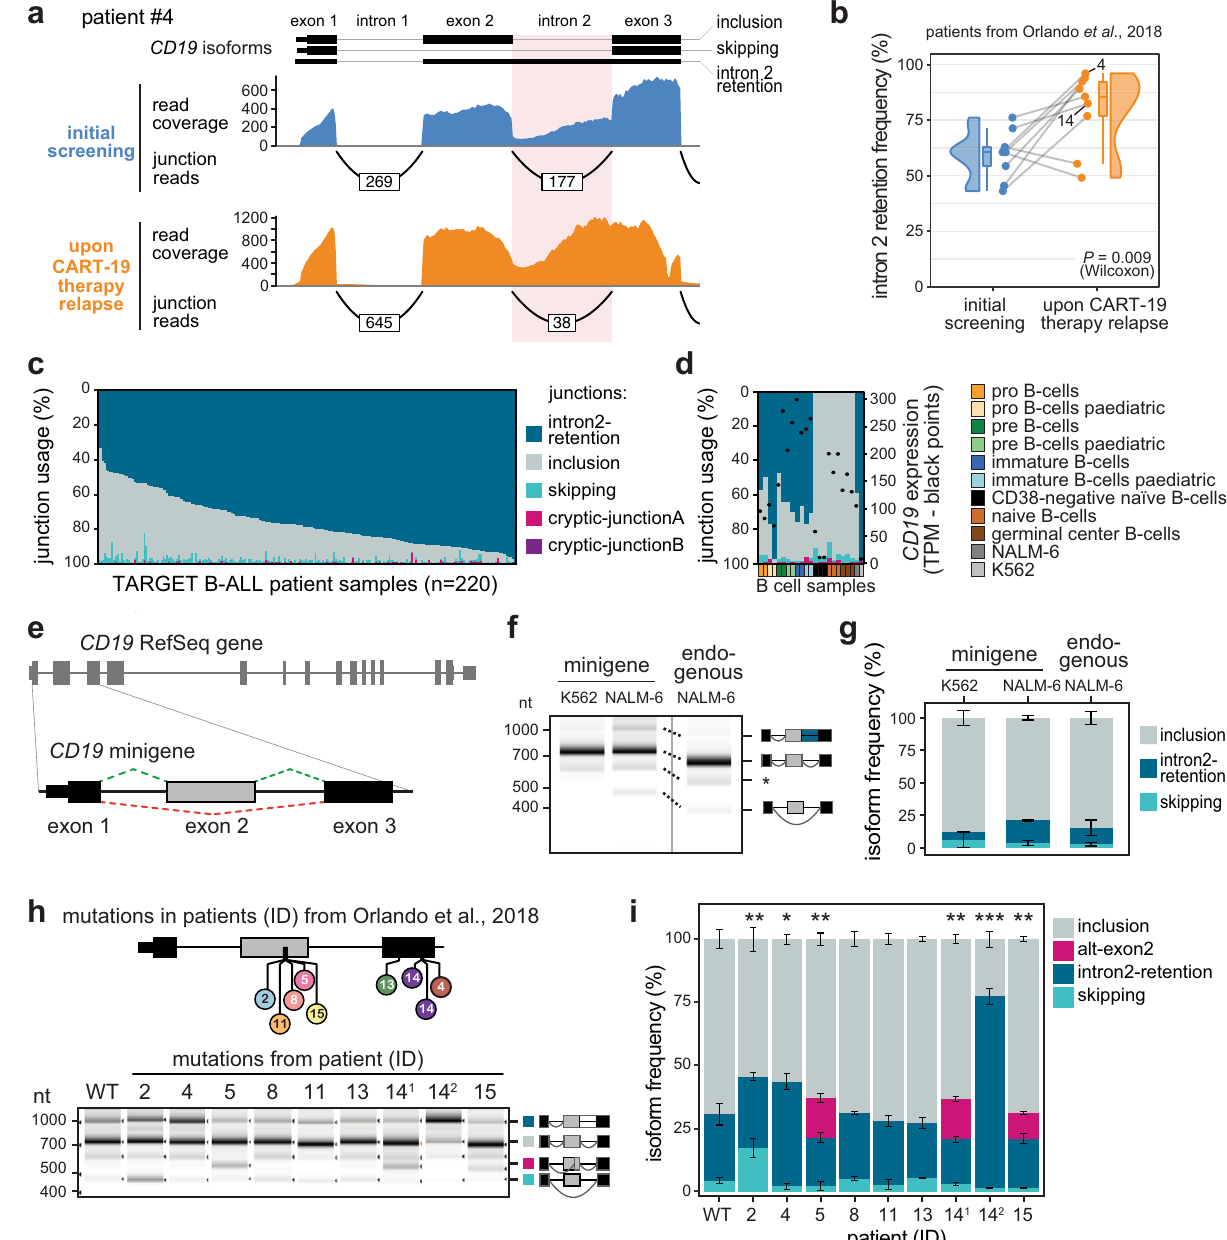
Fig. 1 Mutations from B-ALL patients cause CD19 mis-splicing. a Patient #4 shows increased CD19 intron 2 retention after CART-19 therapy relapse. Re- analysed RNA-seq data from Orlando et al. 5 . Selected isoforms (GENCODE) are shown. b Intron 2 retention increases in B-ALL patients after CART-19 therapy relapse. Intron 2 retention frequency (as % of all isoforms) is shown for nine patients with matched RNA-seq data at screening and after relapse. P value = 0.009, one-sided paired Wilcoxon signed-rank test. Grey lines connect matched samples. Boxes represent quartiles, centre lines denote 50th percentile, and whiskers extend to most extreme values within 1.5× interquartile range (IQR). c , d Intron2-retention is the predominant isoform in B-ALL patients and pre B cells. Stacked bar chart shows relative usage (percent selected index, PSI; left y axis) of junctions originating from exon 3 (Supplementary Fig. 1a) in 220 patients from the TARGET B-ALL programme ( c ) and normal B cells 44, 75 ( n = 21) ( d ). Black dots in d indicate total CD19 mRNA expression, in transcripts per million (TPM; right y axis). Cell lines NALM-6 and K562 are shown for comparison. e The CD19 minigene spans exons 1 – 3 and the intervening introns from the CD19 gene. f , g The minigene generates the same isoforms as the endogenous CD19 gene in NALM-6 cells. Gel-like representation ( f ) and quanti fi cation ( g ) of semiquantitative RT-PCR showing isoforms intron2-retention (blue), inclusion (grey) and skipping (turquoise) for the WT minigene in NALM-6 cells. Isoforms of CD19 gene in NALM-6 cells are shown for comparison. Asterisk indicates a previously reported RT-PCR artefact 66 (see Methods). Error bars indicate standard deviation of mean (s.d.m.), n = 3 replicates. P value > 0.1 for all isoforms, one-way ANOVA. h , i Patient mutations cause splicing changes in the CD19 minigene. Top: Location of the tested mutations. Patient IDs as reported in Orlando et al. 5 . 14.1 and 14.2 correspond to distinct mutations from patient #14. Gel-like representation ( h ) and quanti fi cation ( i ) of semiquantitative RT-PCR as in f , g . Additional isoform alt-exon2 (purple) includes a truncated version of exon 2. Error bars indicate s.d.m., n = 3 replicates. * P value < 0.05, ** P value < 0.01, *** P value < 0.001, two-sided Student ’ s t test. Source data including P values are provided as a Source Data fi